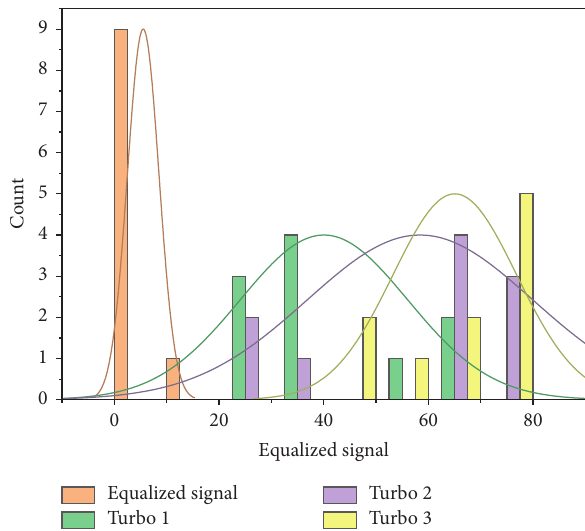
Figure 11: Simulation results of the high-speed hydroacoustic OFDM communication system based on balanced Turbo